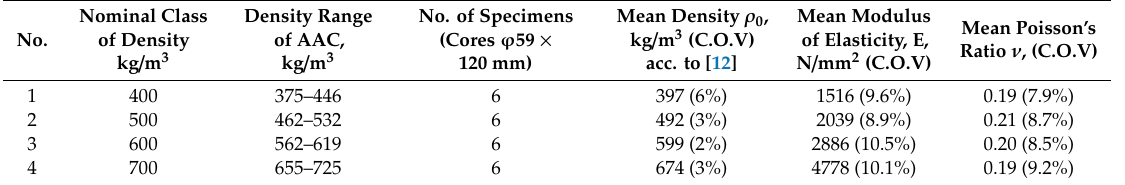
Table 1. Fundamental characteristics of masonry